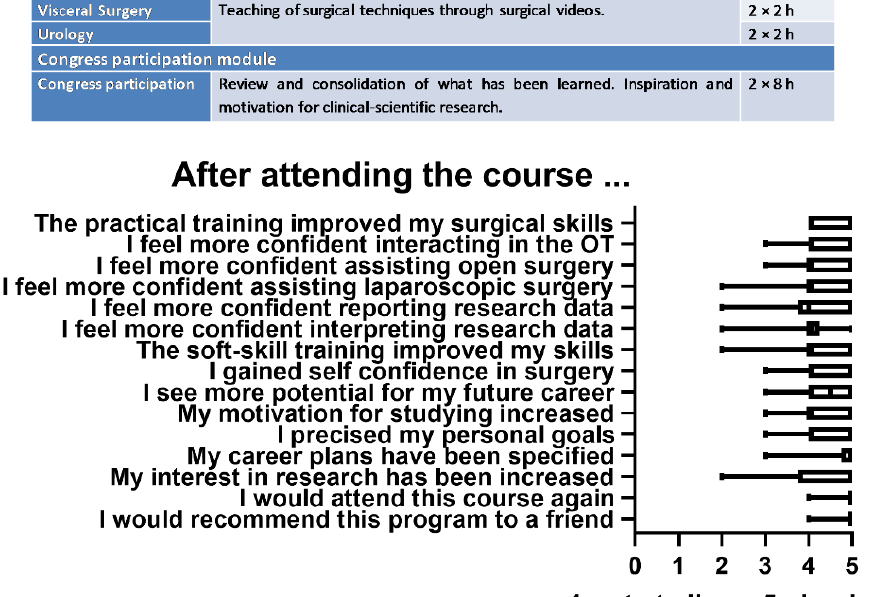
Figure 1. ( A ) The SOCIUS Mentoring Program. Structure and content of the curriculum. ( B ) Boxplots showing the evaluation of the course by the students after completion of the modules (1 bring the lowest agreement and 5 being the highest agreement).